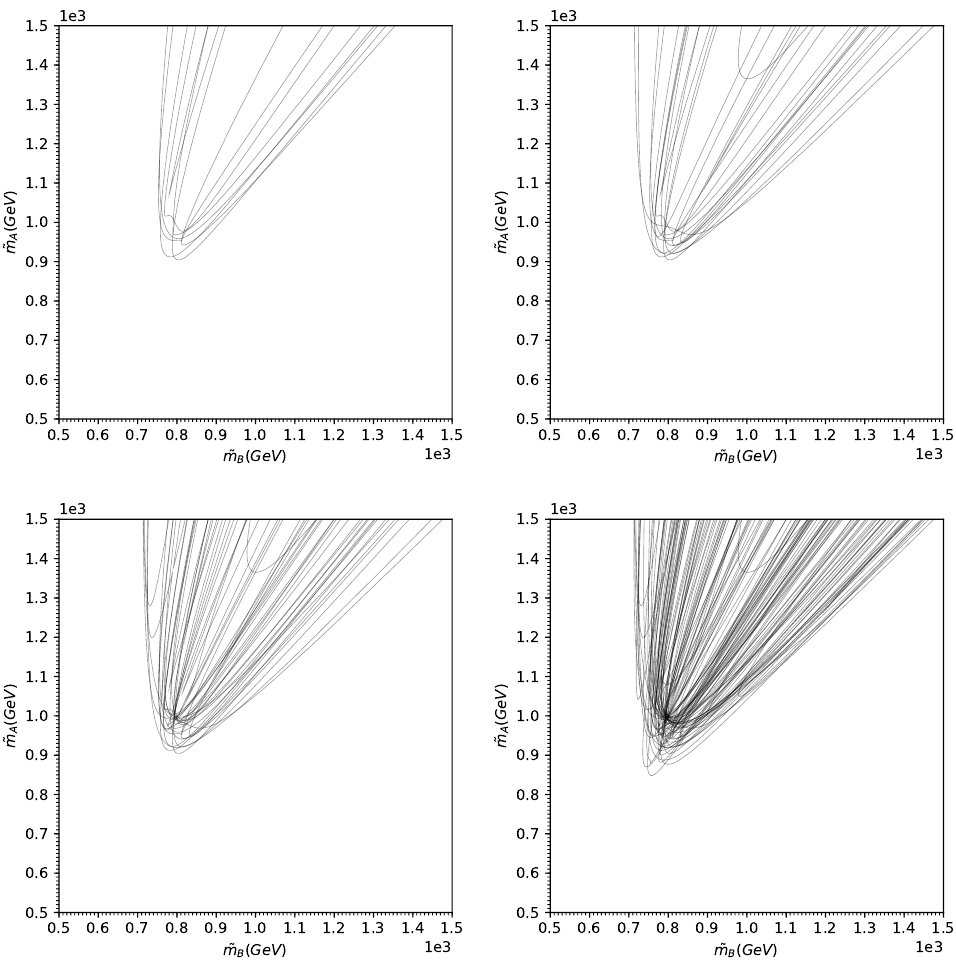
Figure 14 . Degeneracy curves in the ( ~ m plots are made with an increasing number of events: 5 events (top left), 10 events (top right), 20 events (bottom-left) and 50 events (bottom right). Each subsequent panel already contains the events plotted previously, plus some new events. Note the gradual emergence of the focus point of boundary curves near the true mass m